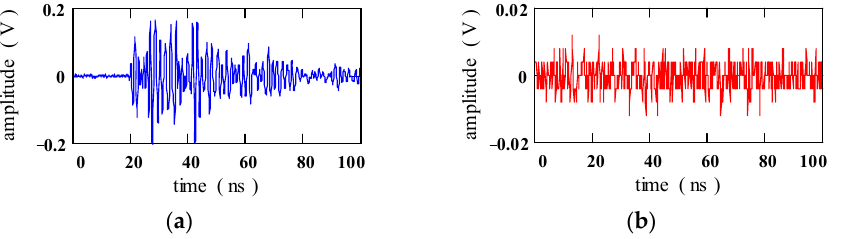
Figure 23. ( a ) A 100 ns portion of the S2 UHF signal taken from the signal in Figure 20. ( b ) A portion of S2 background signal selected from the same record.